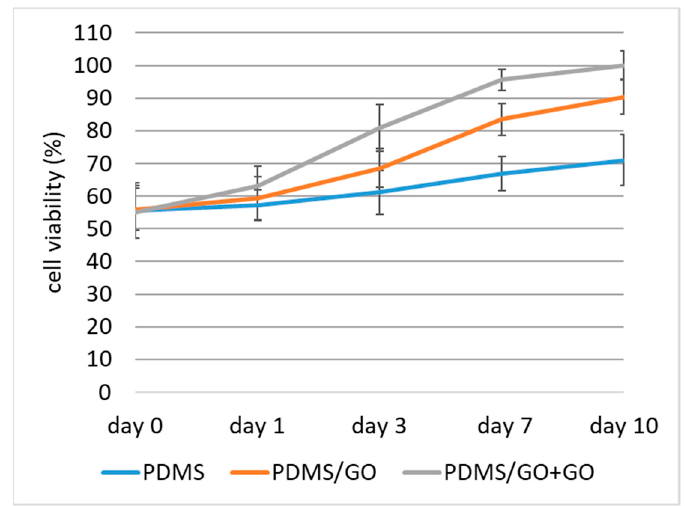
Figure 8. Viability of human induced pluripotent stem cell ‐ derived retinal pigment epithelium cells (hiPSC ‐ RPEs) cultivated on pure PDMS with or without GO enrichment and coating. The cell proliferation was evaluated by using the MTT colorimetric assay, and the cell viability of hiPSC ‐ RPEs cultivated on different scaffolds were measured during a 7 ‐ day time course. A stimulatory effect of both GO enrichment and coating on cell survival was observed. PDMS/GO + GO exhibited the optimal cell viability compared to other groups.